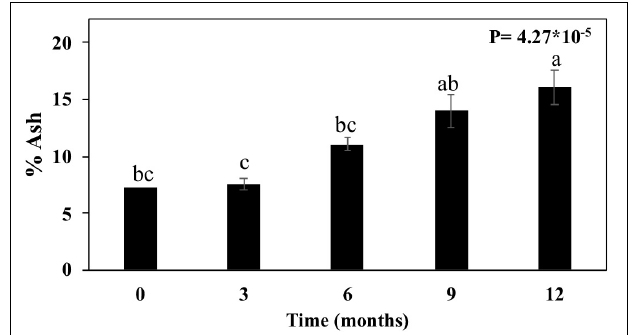
FIGURE 7 | Ash content in sugarcane straw of different ages. Bars represent average ± standard error. Different letters are significant differences by Tukey’s test ( P < 0.05; n = 5).